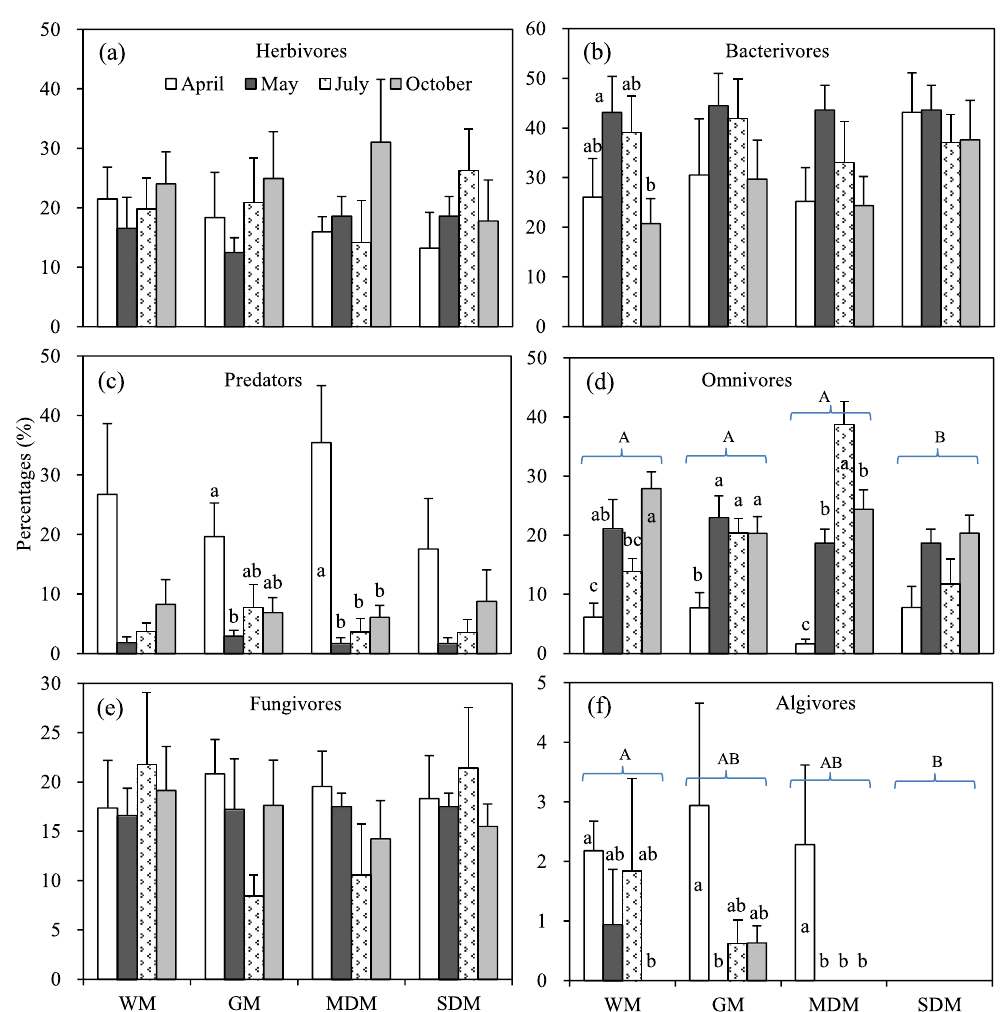
Figure 6. Spatio-temporal variations of the relative abundances of the six trophic groups across the four habitats (mean + SE). Lower-case letters indicate temporal differences within habitats at the P < 0.05